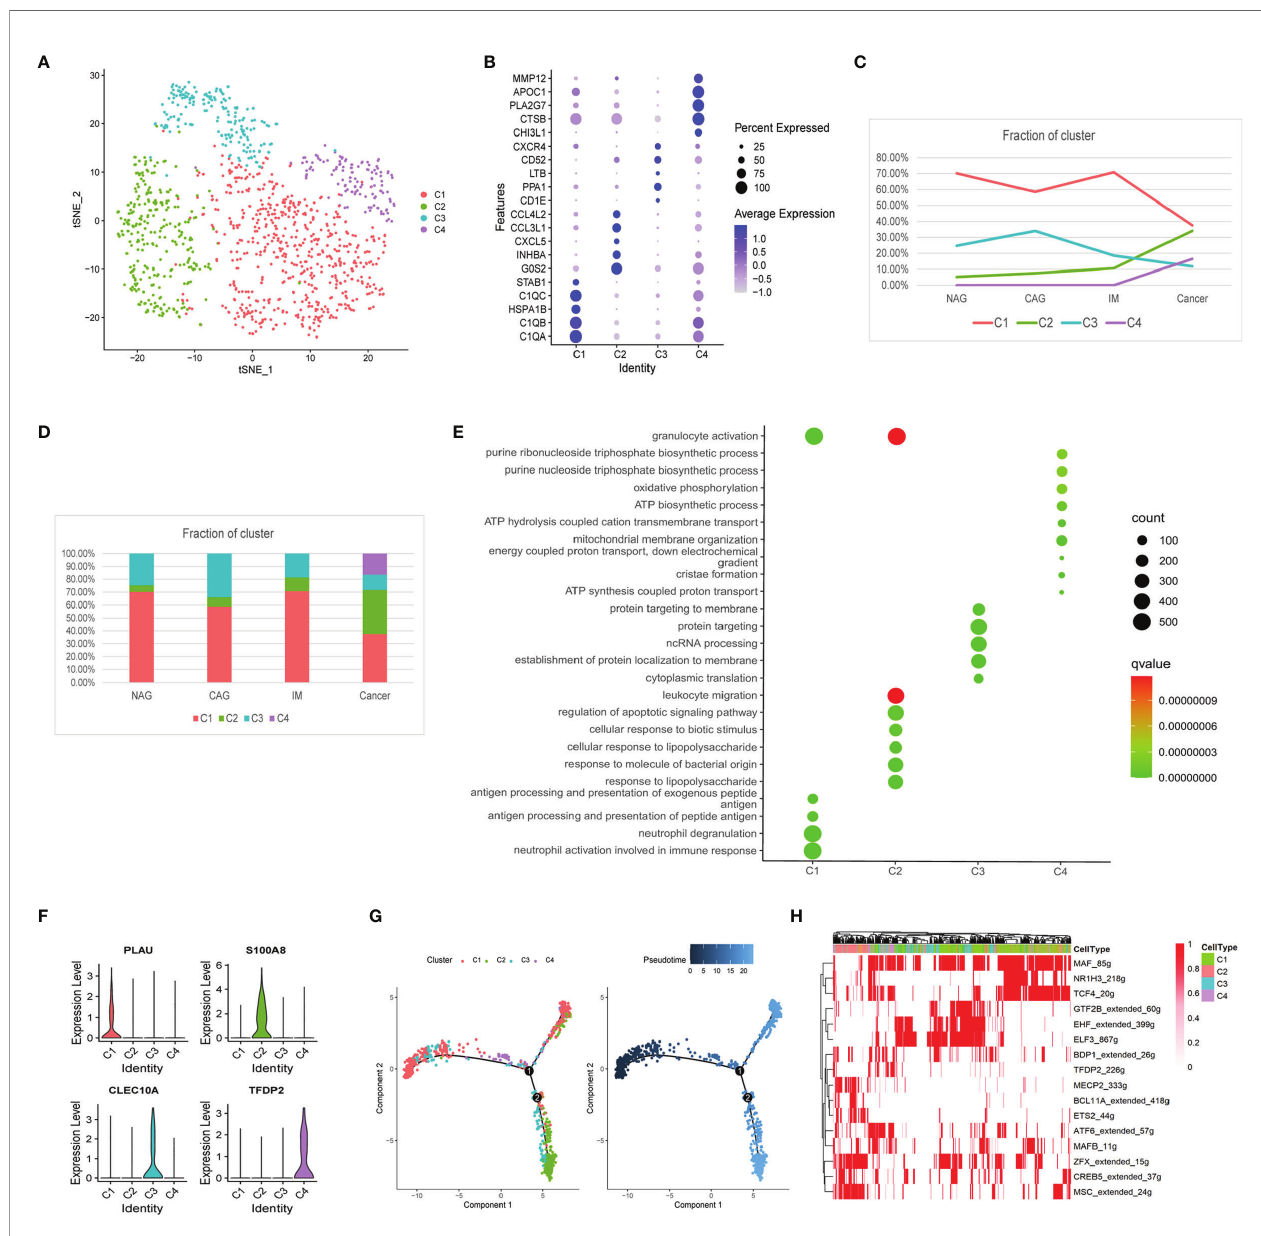
FIGURE 2 | Changes in the composition of macrophages, gene expression, and functions at different stages. (A) tSNE plot of the four macrophage subclusters. (B) A bubble plot of the top fi ve markers of each cell cluster; dot size represents abundance while the color represents expression level. (C) Line chart showing the trend of the proportion of the four clusters across the four stages. (D) Stacked histogram showing macrophage composition across the four stages. (E) Bubble plot showing the biological function of different cell clusters using GO; dot sizes represent abundance while the color represents q values. (F) Violin plots of marker genes in the four subclusters. (G) The differentiation trajectory of macrophages. Sections are color coded for pseudotime (right) and clusters (left). (H) AUC scores of TF expression regulation using SCENIC. Results converted to binary data were visualized as heatmap plots constructed using the pheatmap function of